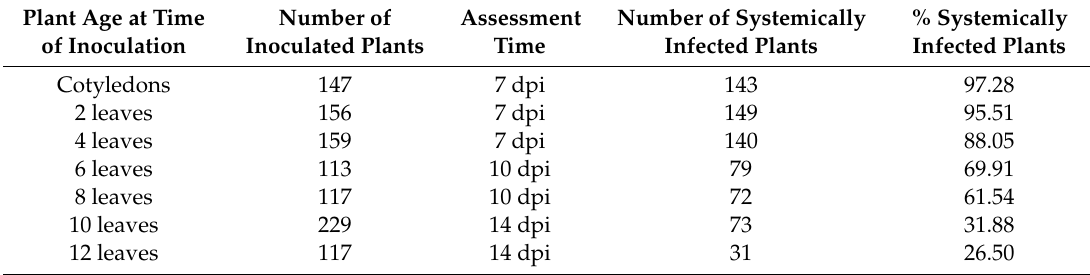
Table 1. The relationships between plant age and systemic spread of Peronospora belbahrii in basil plants. For the method of inoculation, see Figure 1.